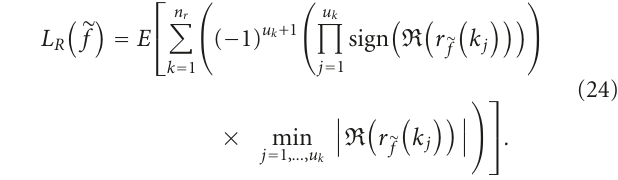
Figure 3 shows the variation of J h ( (cid:2) θ ) in terms of ( (cid:2) θ − θ 0 ), in a noise-free channel for the same LDPC code previously introduced but this time we consider the 16-state Quadrature Amplitude Modulation (16-QAM) case. It is clear that optimizing function J h ( (cid:2) θ ), which is minimum at a phase (cid:2) θ = θ ff set of the channel. 0 , gives an estimate of the phase o